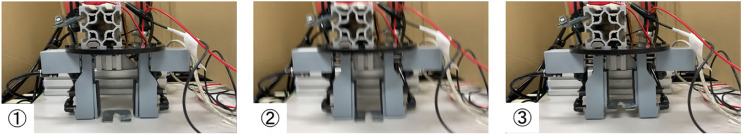
Gripping and releasing a metal plate the two fingered pneumatic gripper.